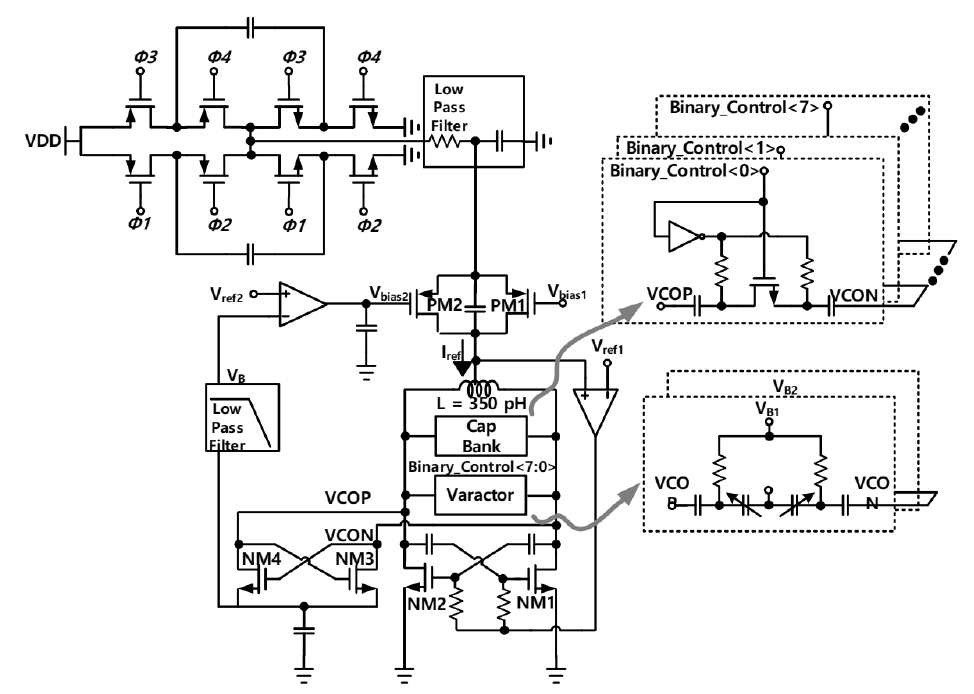
Figure 4. Schematic of the constant amplitude control class-C VCO with DC-DC